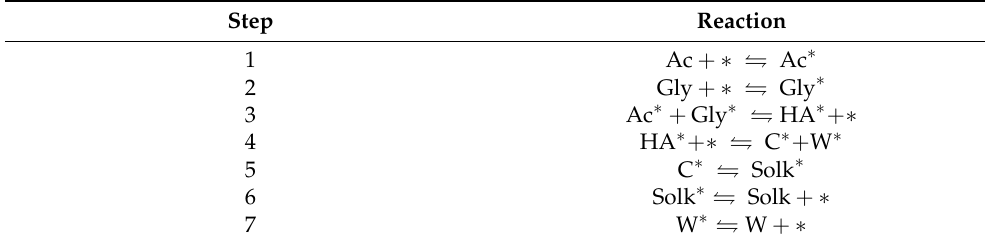
Table 6. Steps involved in the kinetic model proposed.